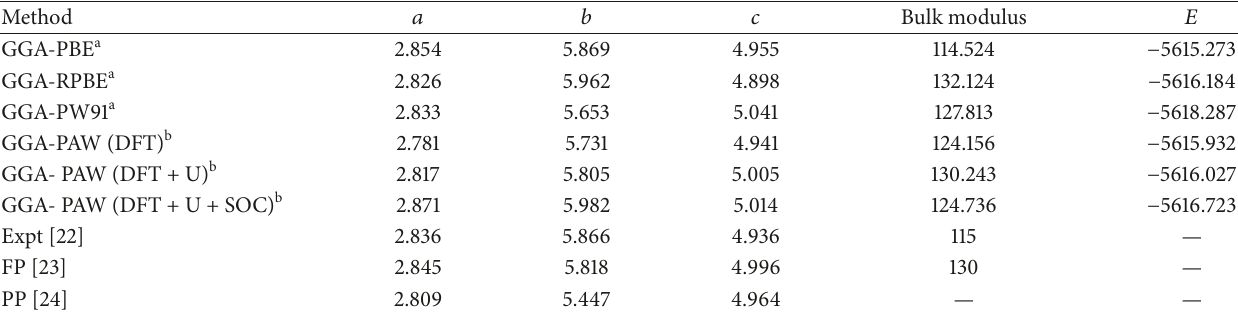
Table 1: Equilibrium lattice parameters (in ˚A), bulk modulus (in GPa), and total energy E (in eV) of uranium crystal.